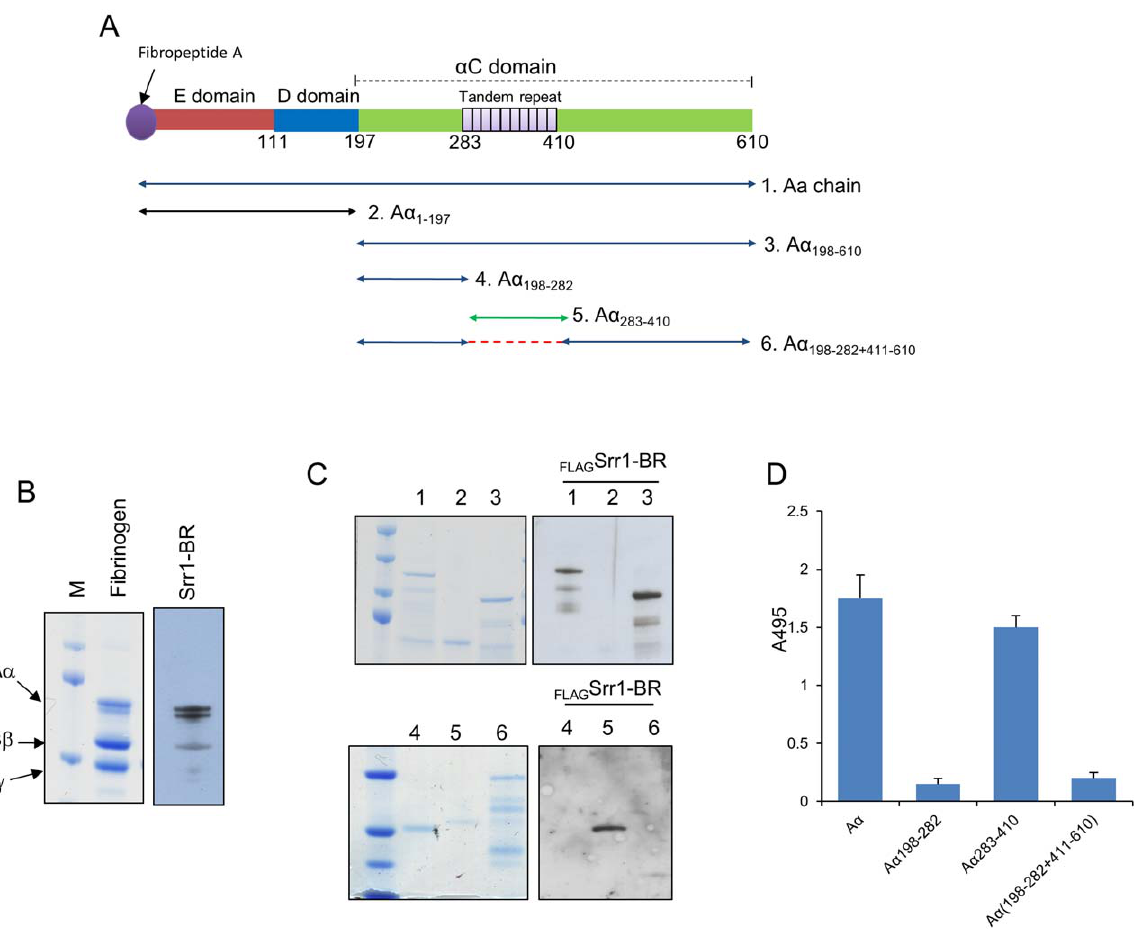
Figure 6. Srr1-BR binding to a C domain of the fibrinogen A a chain. (A) Schematic of fibrinogen A a organization. The 10 tandem repeating units of the a C domain are represented by the purple bars. Arrows # 1–6 indicate the truncated forms of A a chain tested. (B) Binding of FLAG Srr1-BR to fibrinogen A a chain. Purified human fibrinogen was separated by SDS-PAGE and stained with Coomassie blue (left) or transferred to nitrocellulose and probed with FLAG Srr1-BR (5 m g/ml; right). (C) Recombinant MalE-A a variants were separated by SDS-PAGE and stained with Coomassie blue (left) or transferred to nitrocellulose and probed with FLAG Srr1-BR (right). (D) FLAG Srr1-BR (2 m g/ml) was incubated with immobilized recombinant MalE-A a variants. Binding was detected by ELISA with anti-FLAG antibody. Bars indicate the means ( 6 S.D.).